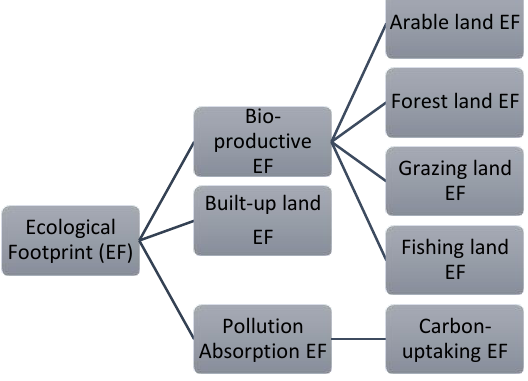
Figure 1. Classification structure chart of ecological footprint.